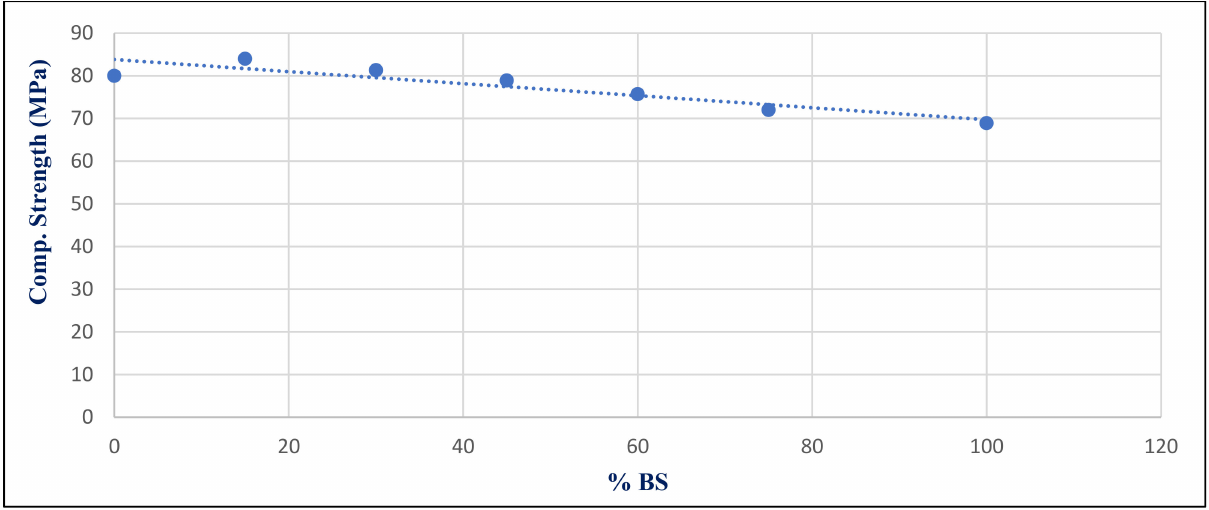
Figure 35. Correlation relation between %BS and compressive strength for group Z at 750 ◦ Cat day 28.